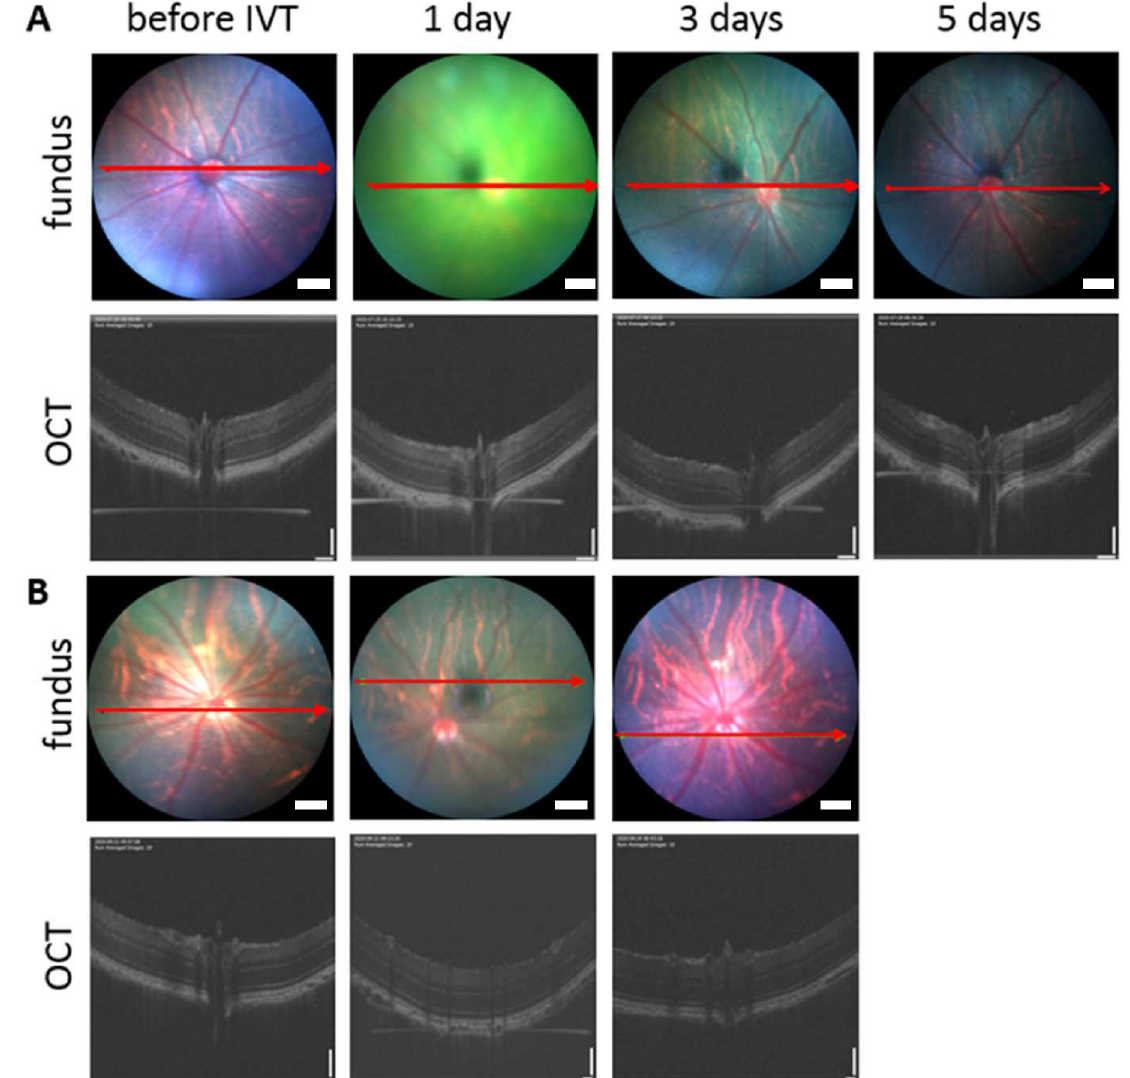
Figure 11. Fundus and optical coherence tomography (OCT) images of rat vitreous and retina. The figures are before and after intravitreal injections (1, 3 and 5 days) of BDP-pullulan ( A ) and BDP- pullulan-DEX ( B ). The length of scale bar for fundus images are 200 µ m. In the case of OCT, vertical and horizontal scale bars in OCT are 110 and 130 μ m, respectively.